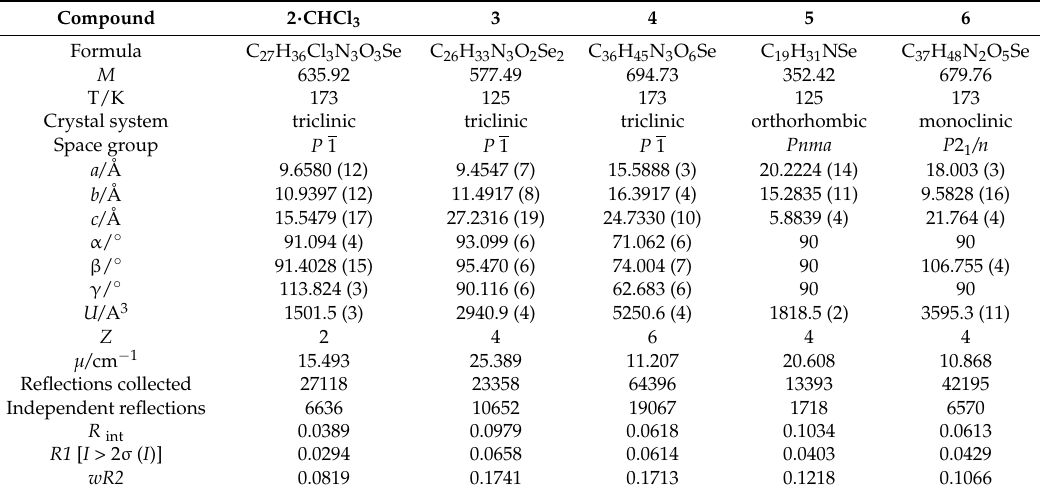
Table 1. Details of the X-ray data collections and refinements for compounds 2 – 6 .